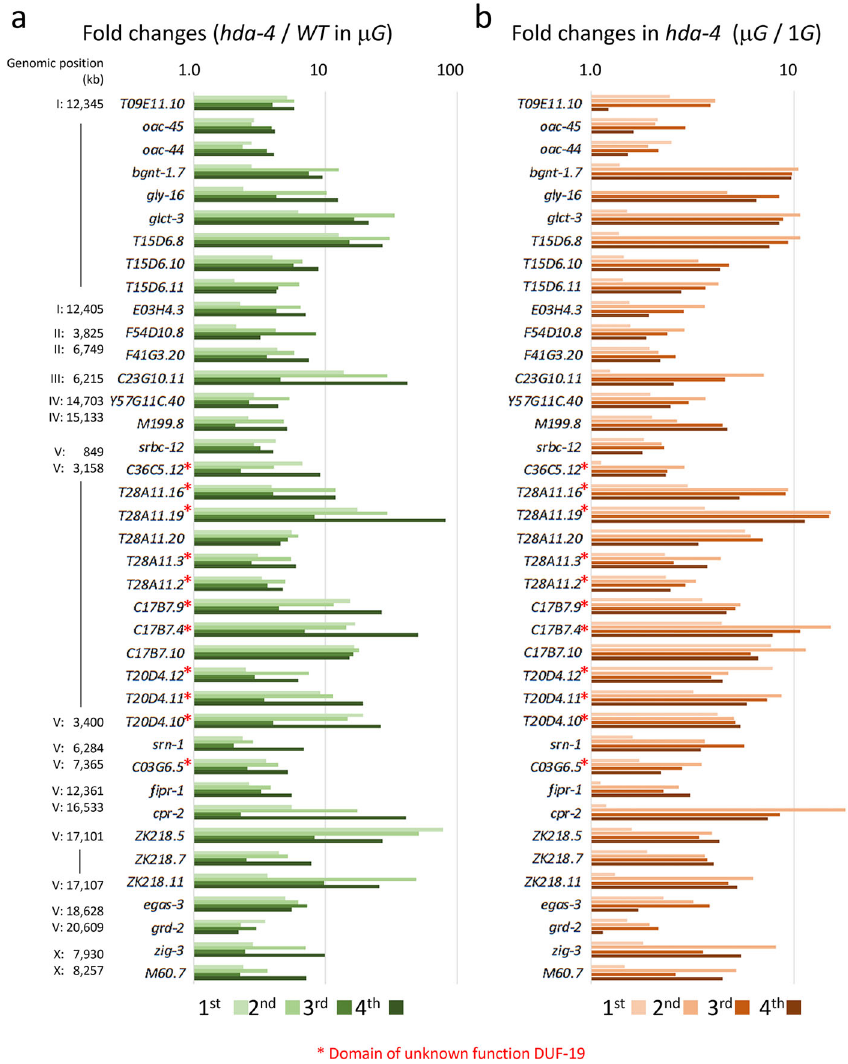
Fig. 2 Changes in gene expression induced in hda-4 (ok518) mutants grown under microgravity conditions. a DNA microarray analysis was compared through four generations of wild-type and hda-4 mutant strains grown under microgravity in two independent replicate experiments. All 39 genes were signi fi cantly upregulated in the hda-4 mutant (>2.5-fold, p < 0.05 using Student ’ s t test). Statistical analysis was performed between the mean values of the four generations of wild-type and hda-4 mutants. Their chromosome positions and expression levels (fold-change values) were indicated. b Changes in gene expression (fold-change values) of 39 genes in the ( a ) of hda-4 mutants grown under microgravity and arti fi cial 1 G conditions. Asterisk (*) indicated genes containing a domain of unknown function